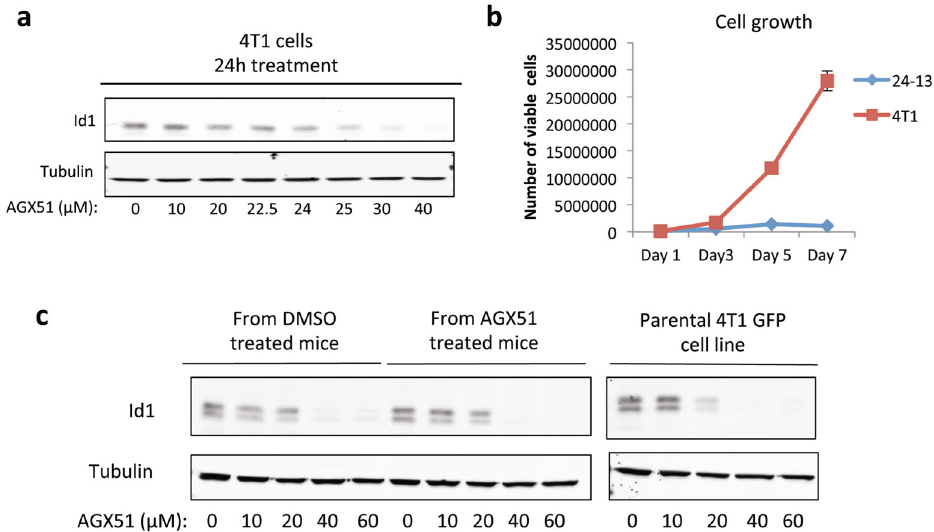
Fig. 6 Generation of AGX51-resistant cell lines. a Western blot for ID1 on whole-cell lysates from 4T1 cells treated with 0 – 40 µM AGX51 for 24 h. b Cell growth of 4T1 cells and the AGX51 transiently resistant cell line clone 24-13, as determined by cell counting over 7 days. Mean of technical triplicates is shown with error bars representing SEM. c Cells were FACS isolated from the lungs of mice that were injected with 5 × 106 GFP-labeled 4T1 cells via tail vein and treated with 50 mg/kg bid or vehicle for 2 weeks. The isolated cells (from DMSO or AGX51-treated mice) and parental GFP-labeled 4T1 cells were treated with 0, 10, 20, 40, or 60 µM AGX51 for 24 h and whole-cell lysates were prepared. Western blot analysis for ID1 was then carried out. Tubulin serves as a protein loading control. See also Supplementary Figs. 11 and